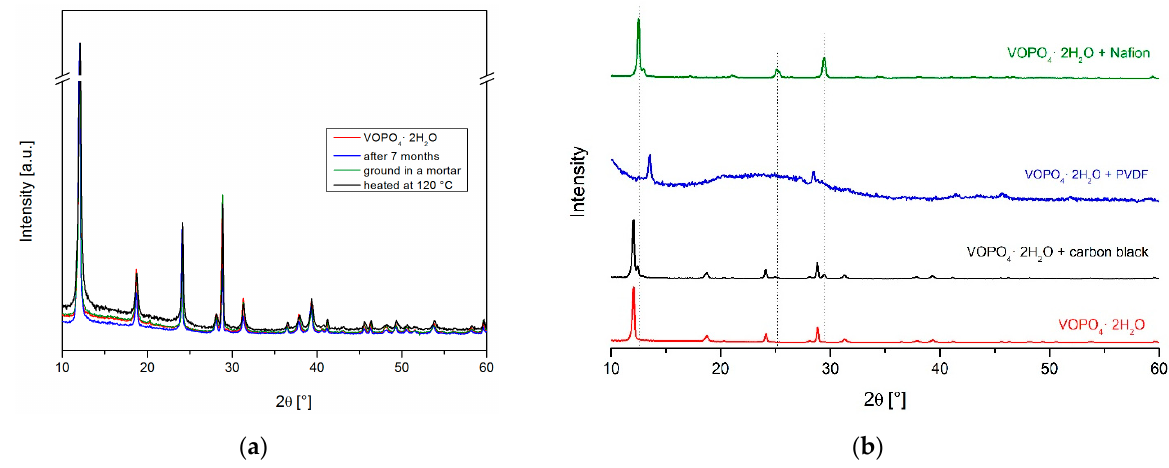
Figure 4. ( a ) XRD patterns of the VOPO 4 ∙ 2H 2 O powder after grinding in a mortar, drying at 120 °C, and ageing in the air for 7 months; ( b ) Comparison of the XRD patterns of the VOPO 4 ∙ 2H 2 O powder, its mixtures with carbon black (PBX51), and carbon black and a binder (PVDF or Nafion).